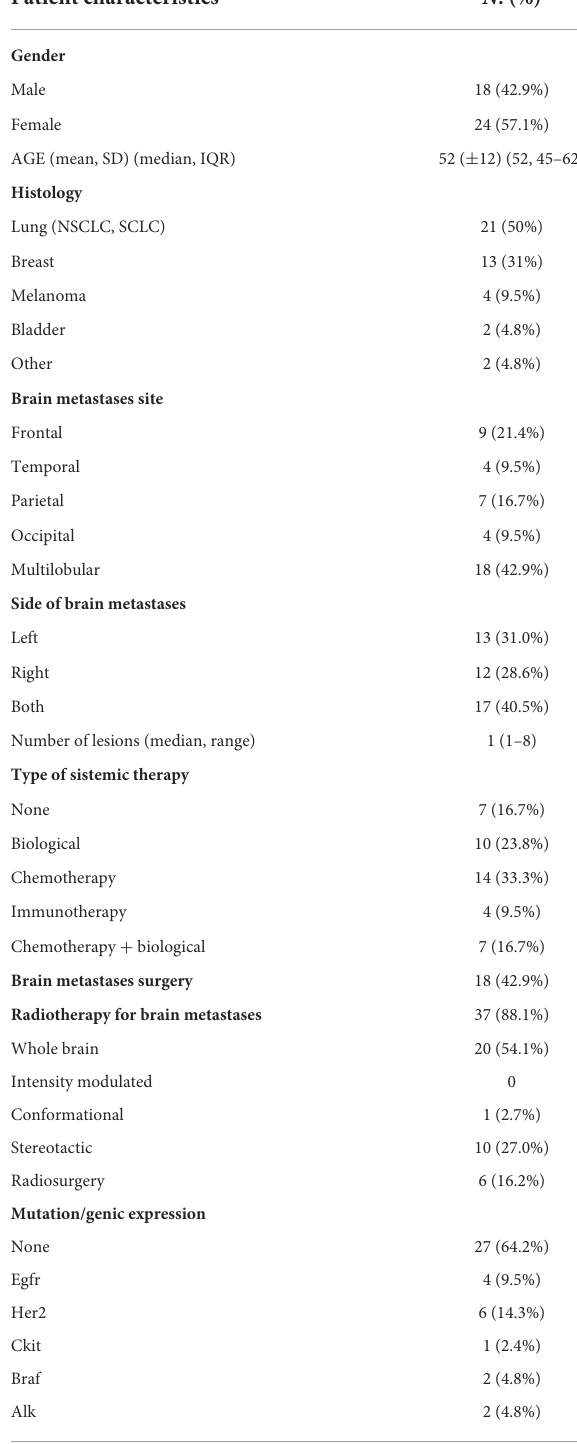
TABLE 2 Demographic and oncological variables of patients who underwent at least a second neurological examination ( n = 42